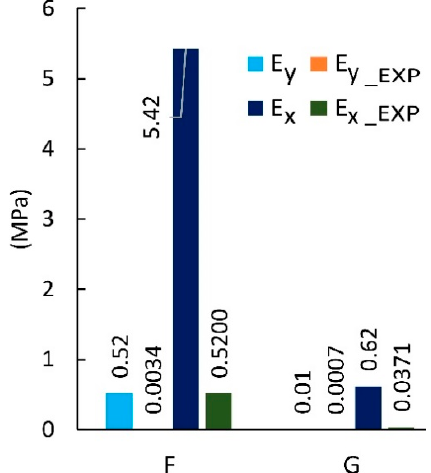
Figure 10. Poisson’s ratio for cells of the type: F, G (EXP-experimental research).